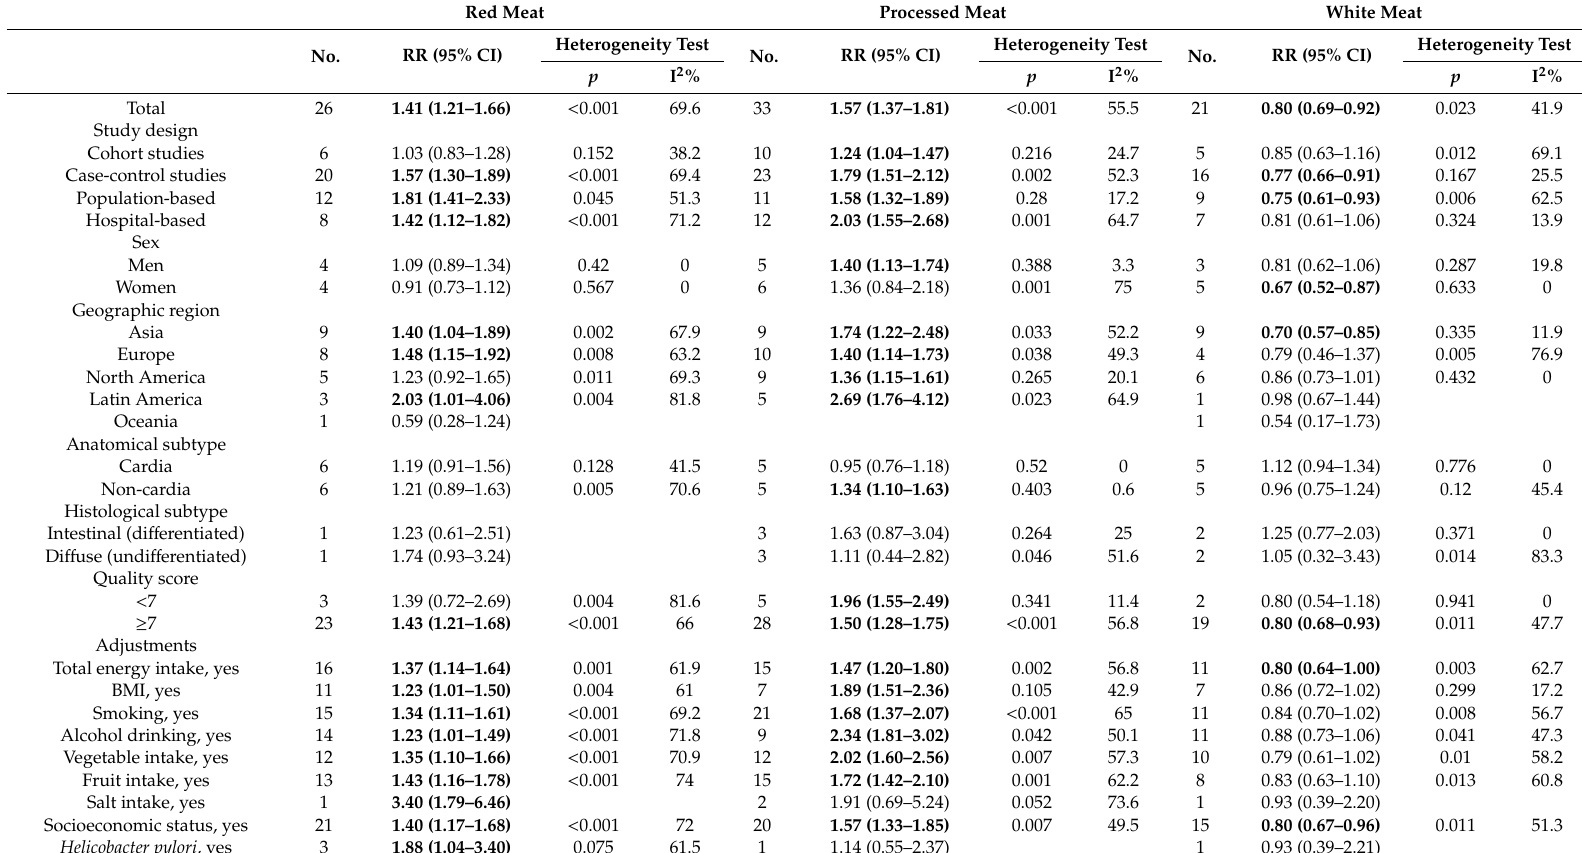
Table 2. Stratified analysis (highest versus lowest categories) of red, processed, and white meat consumption and gastric cancer